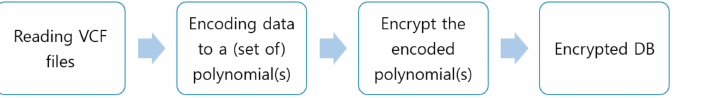
Figure 2. Process of creating an encrypted database in hybrid homomorphic encryption